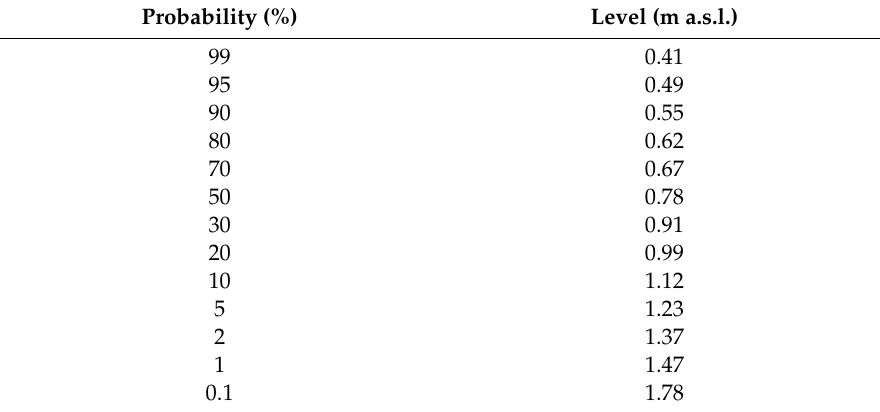
Table 1. Probability of the maximum sea levels in the Gulf of Gda´nsk [10]. Probability (%) Level (m a.s.l.)